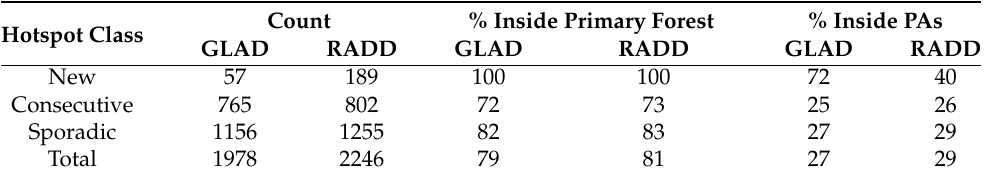
Table 3. The number of hotspot classes and their % overlap in 2019 primary forests and protected areas (PAs) for both hotspot maps that use RADD and GLAD alerts.